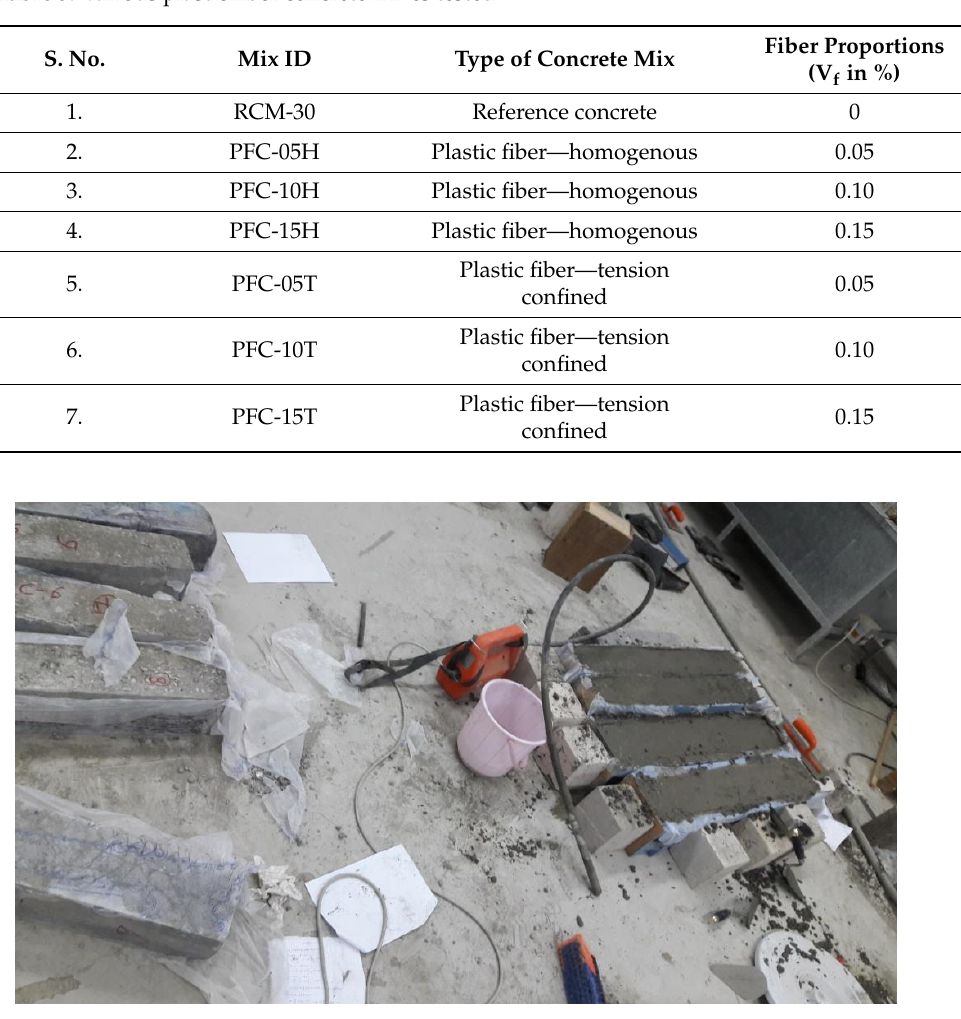
Figure 3. Controlled casting and sealed curing of concrete specimens.